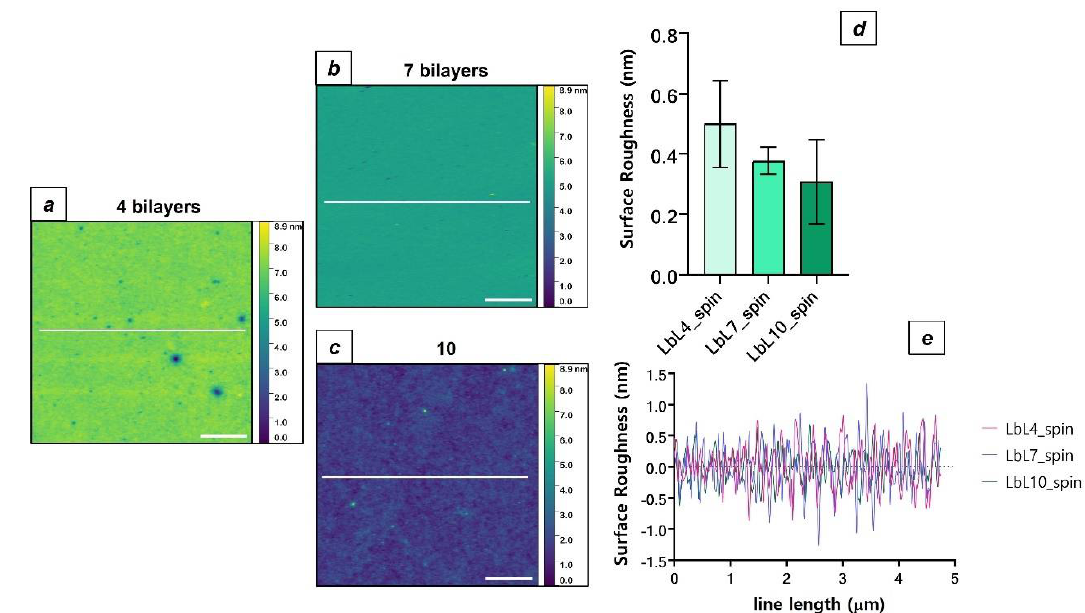
Figure 6. AFM topographical analysis of LbL assembly by spin coating. AFM scan of LbL surface after the deposition of 4 ( a ), 7 ( b ), and 10 ( c ) bilayers. ( d ) Average surface roughness of LbL multilayers with increasing number of bilayers deposited onto the PI surface. ( e ) Plot of surface roughness profile of spin-coated LbL substrates relative to the white line drawn in each AFM scan. Scale bars are 1 μm.